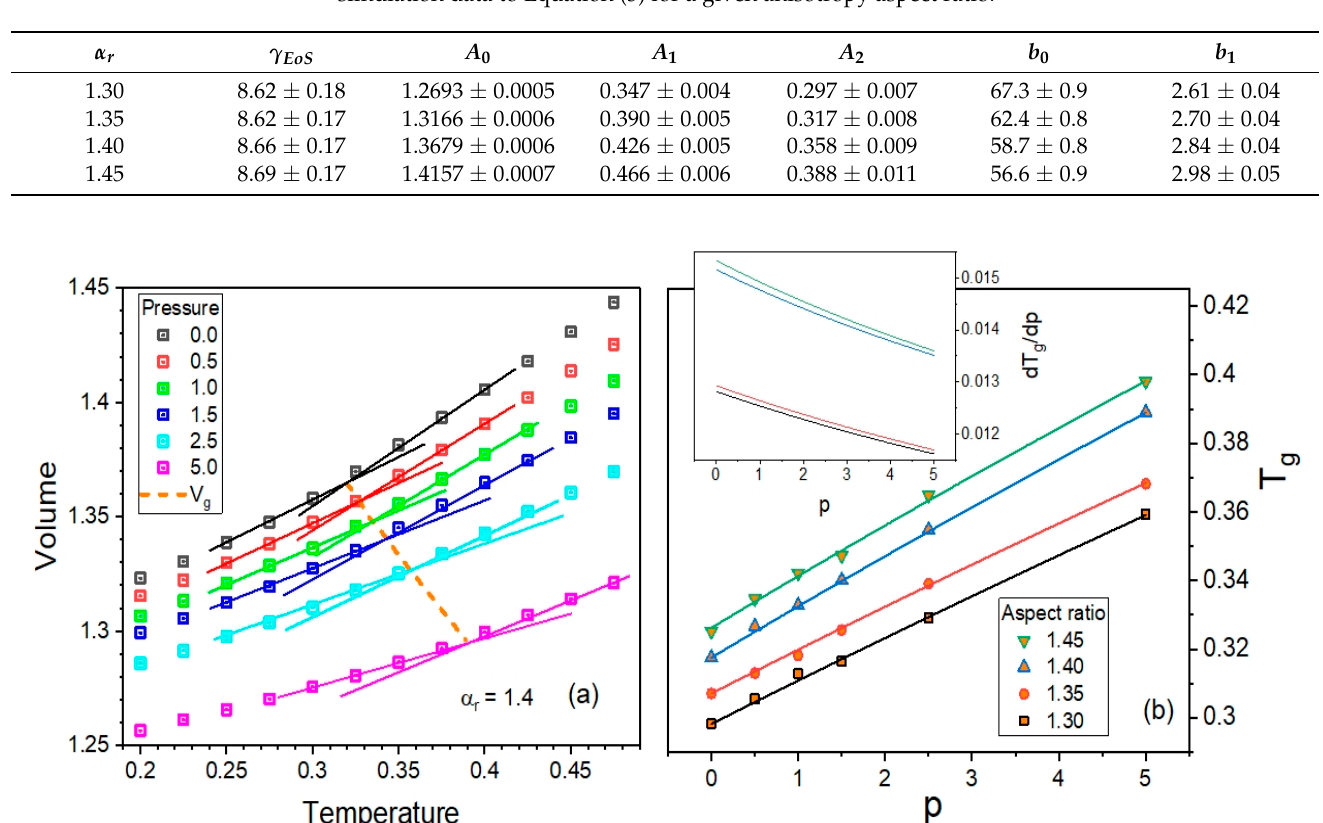
Table 1. The values of the fitting parameters of Equation (3) established for all examined anisotropy aspect ratios in the supercooled liquid state in the GB model. The determination errors of the values of the EoS parameters are estimated as the standard deviation errors found from fitting all pVT simulation data to Equation (3) for a given anisotropy aspect ratio.